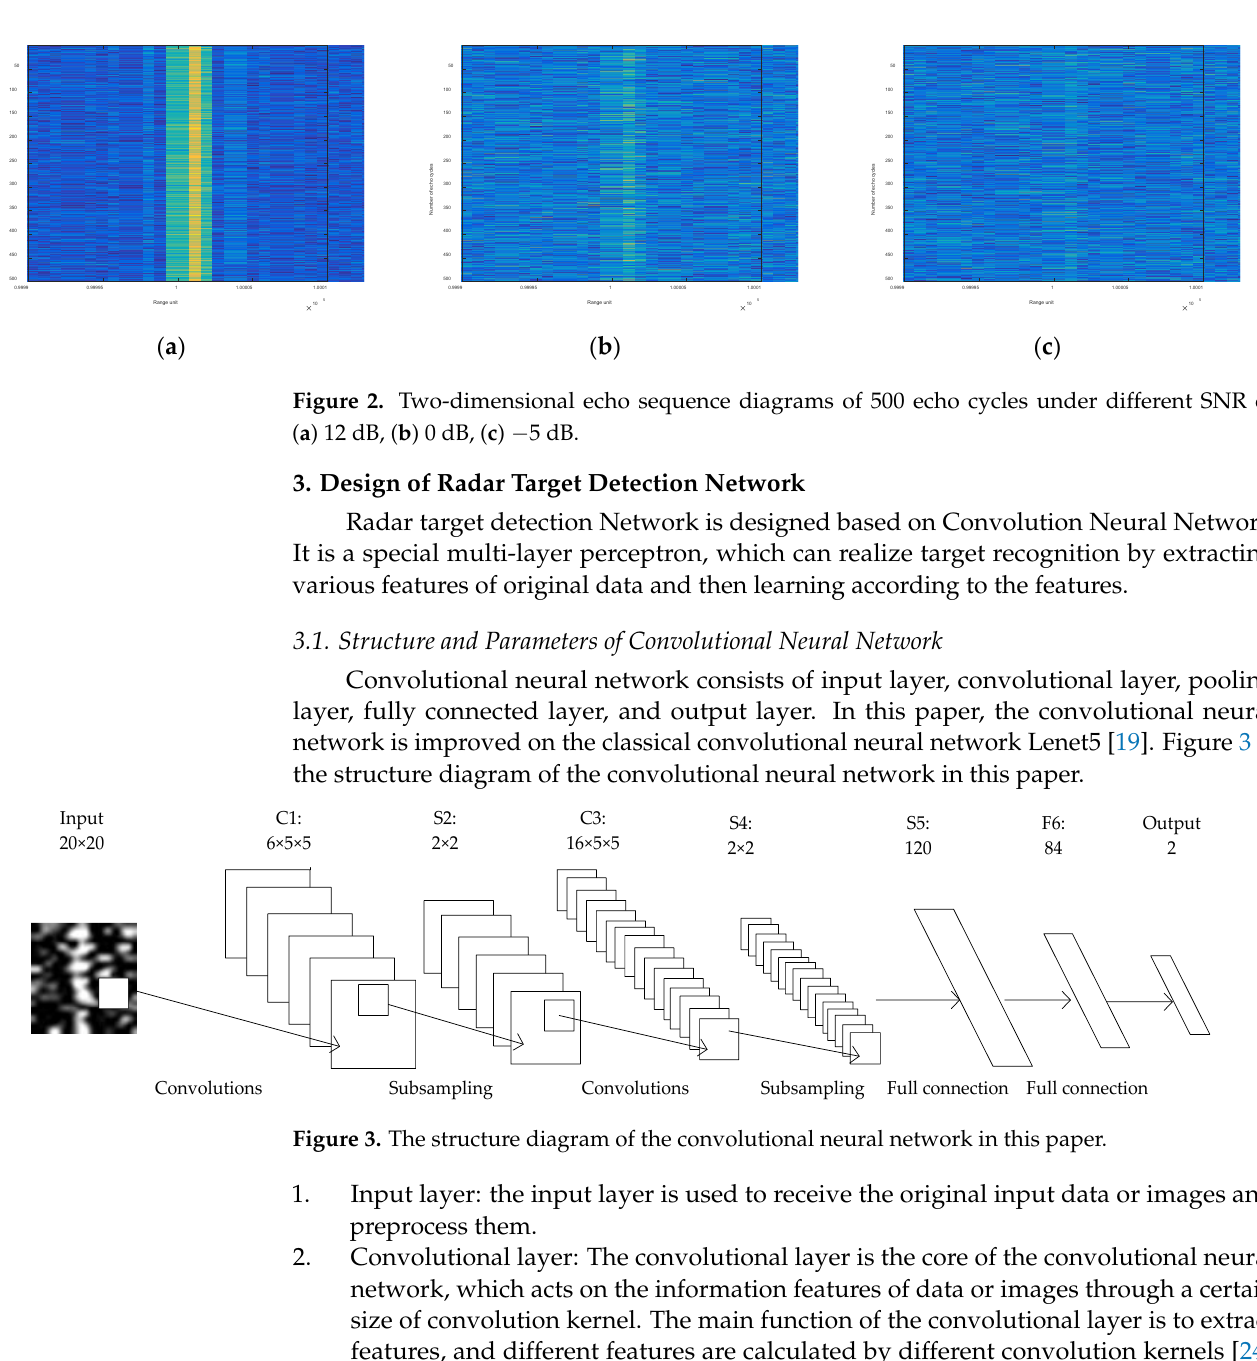
performed. Finally, the first convolution result element is obtained by adding each element of the matrix. Then the convolution operation is performed in turn, and the last convolution result as shown in Figure